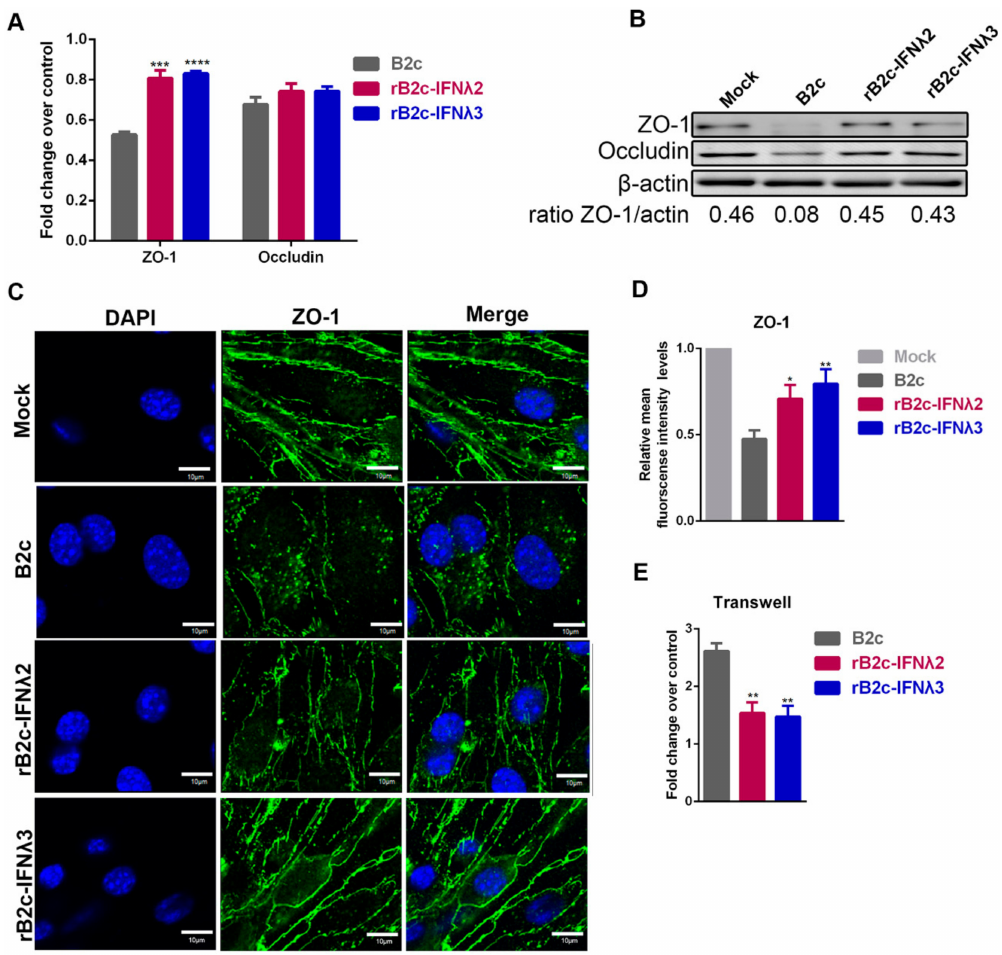
Figure 8. IFN- λ maintains protein expression in tight junctions in b.End3 cells. Mouse brain capillary endothelial (b.End3) cells were co-cultured for 24 h with extracts from supernatants of astrocytes that had been mock-infected with DMEM or infected with B2c, rB2c-IFN λ 2, or rB2c-IFN λ 3 at a MOI of 5. Expression of ZO-1 and Occludin was detected by qRT-PCR ( A ) and western blot ( B ). The integrity of TJ protein ZO-1 was measured by confocal microscopy ( C ). Relative mean fluorescence intensity for the regions of interest (ROI) was determined using Image J ( D ). B.End3 cells were cultured on transwell inserts and treated with extracts from supernatants of astrocytes that had been mock infected with DMEM or infected with B2c, rB2c-IFN λ 2, or rB2c-IFN λ 3 at a MOI of 5. At 24 hpi, FITC-dextran-10000 was added into the upper insert of the transwell and then the permeation of FITC-dextran-10000 into the lower chamber was measured using a fluorimeter (excitation, 492 nm; emission, 520 nm) ( E ). Error bars represent the SE ( n = 3). The following notations were used to indicate significant di ff erences between groups: *, p < 0.05; **, p < 0.01; ***, p < 0.001; ****, p <